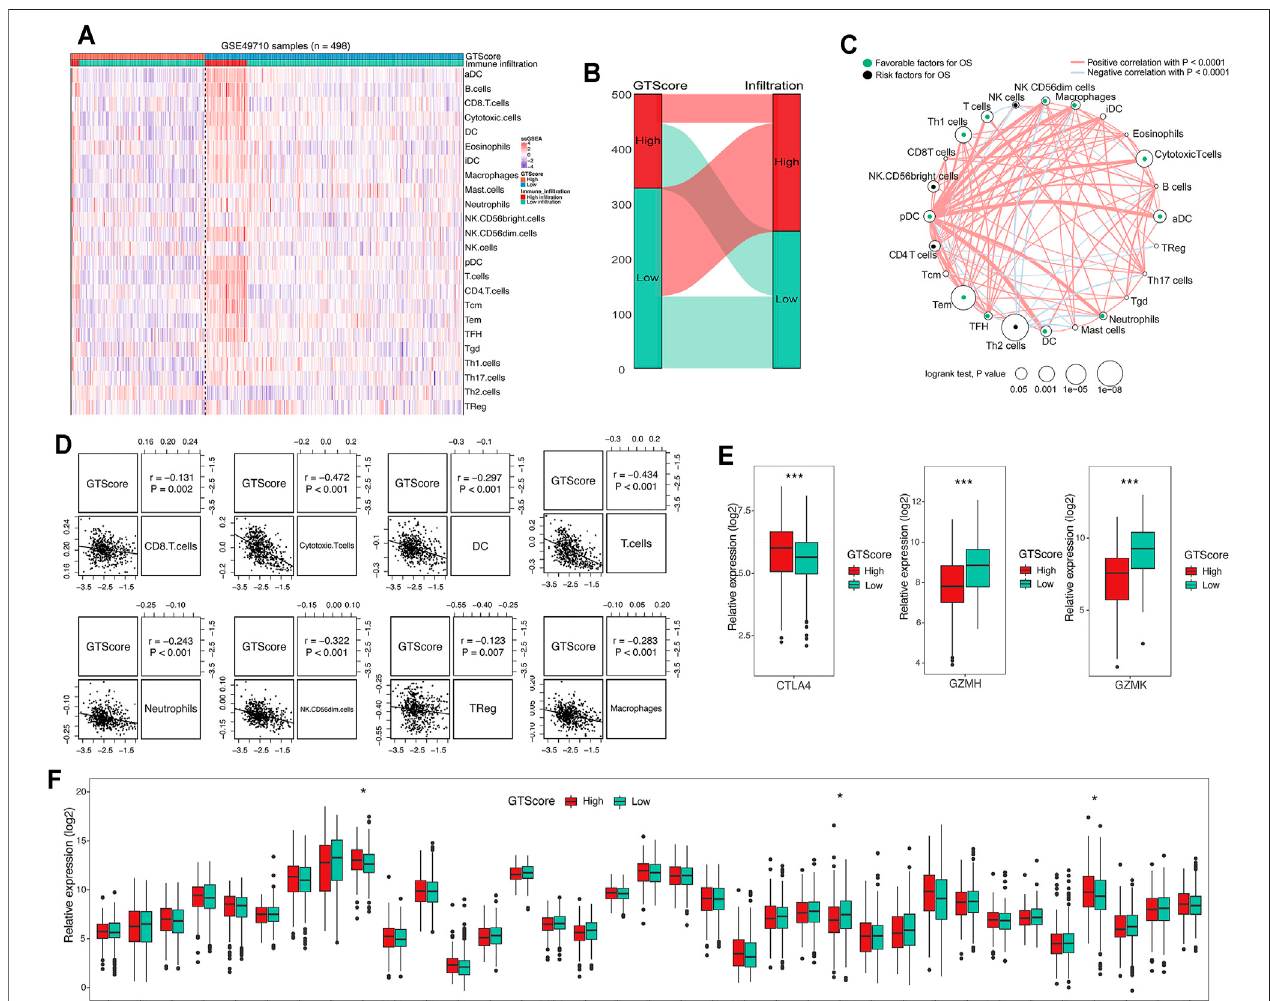
FIGURE7| CorrelationofGTscorewithimmunecellin fi ltration. (A) Heatmapoftheassociationbetweentheriskscoreandtheabundanceof24immunecelltypes inNB. (B) Sankey plotshowingtheassociationbetweenGTscoreandimmunein fi ltration. (C) Cellular interaction oftheimmunecelltypesinNB.Thethickness oftheline represents the strength of the correlation. Correlation between GTscore and immune cell in fi ltration (D) , immune checkpoint genes (E) , and the expression levels of chemokines (F) . * p < 0.05, *** p < 0.001.